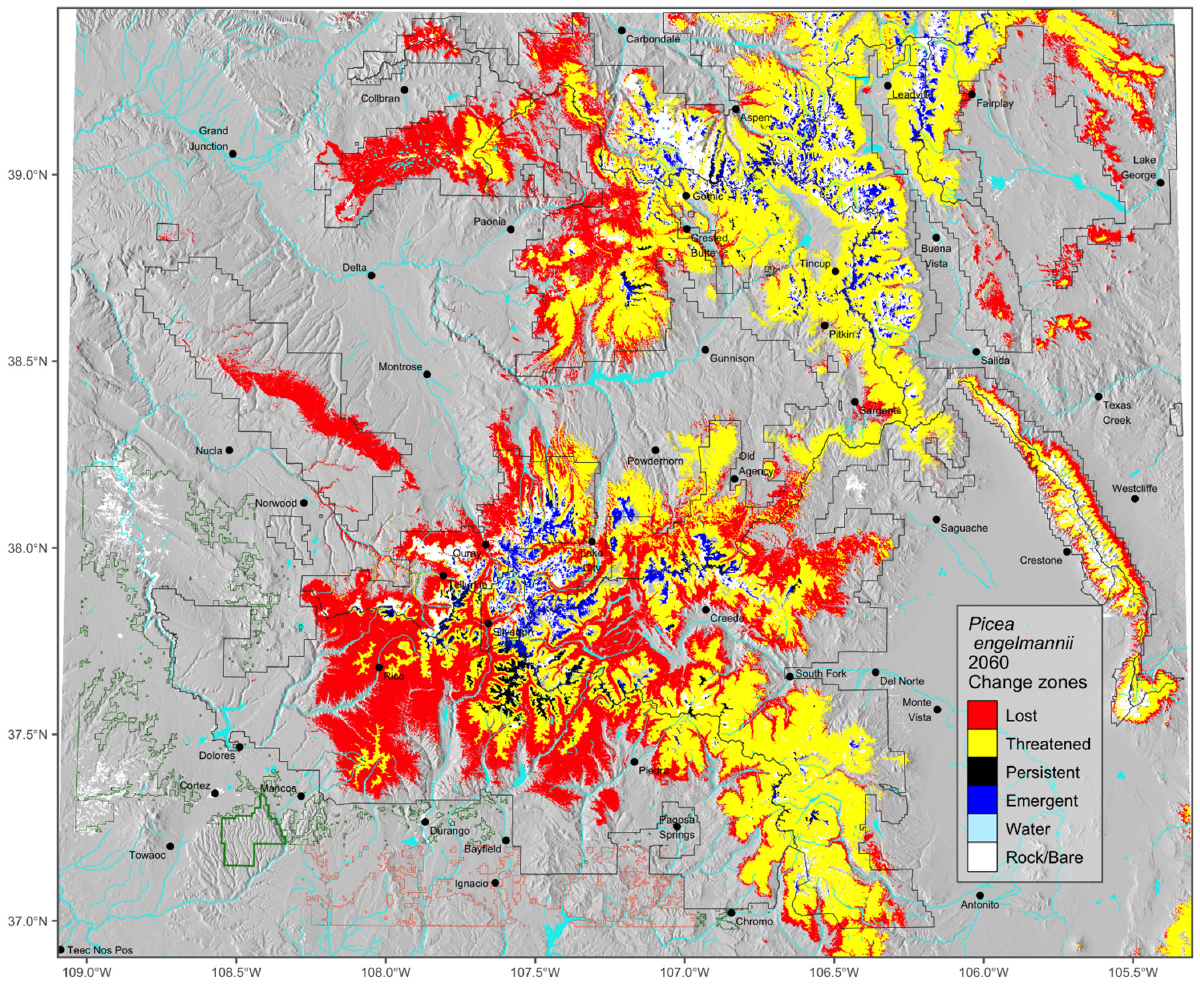
Figure 4. Distribution of change classes in the full model extent for Picea engelmannii , representing projected changes between the reference period (1961–1990) and the decade around 2060 mapped on 90 m gridded DEM.